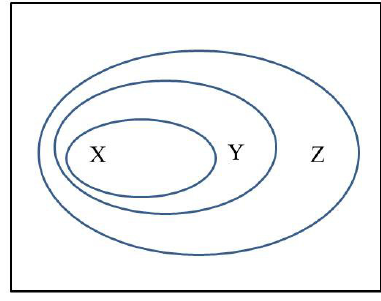
Fig. 1. Illustration of the rule (TRANS).